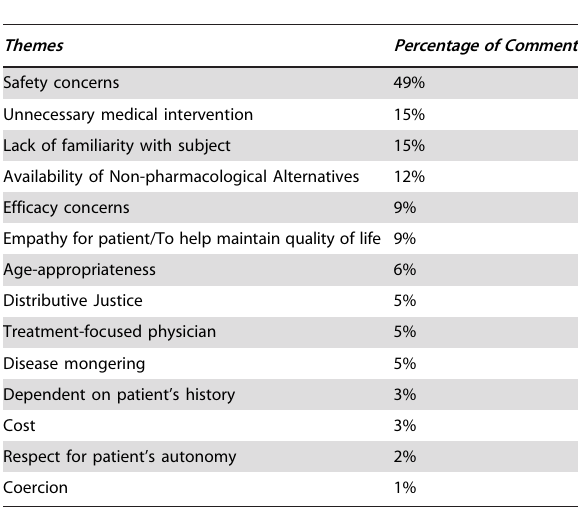
Table 3. Physician General Comments on Prescribing Cognitive